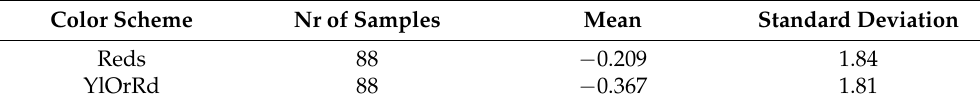
Table 11. Descriptive statistics of error for sequential color schemes.